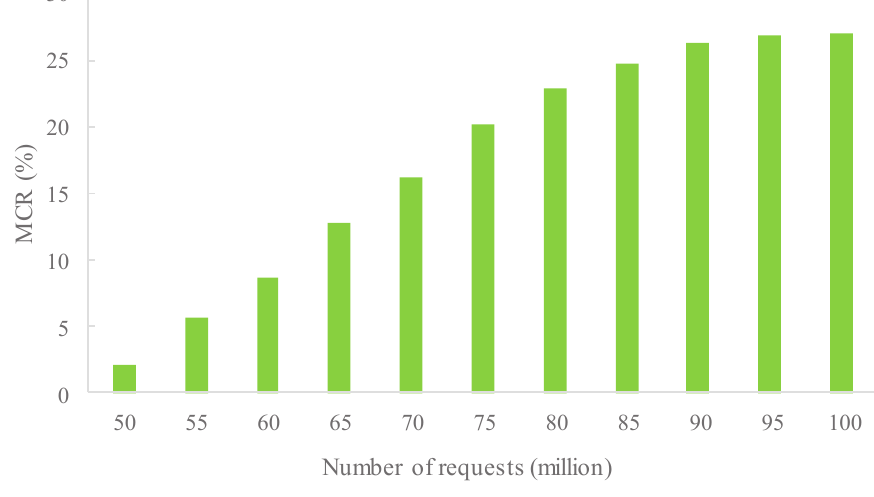
Figure 11. Migration cost of varied number of access service